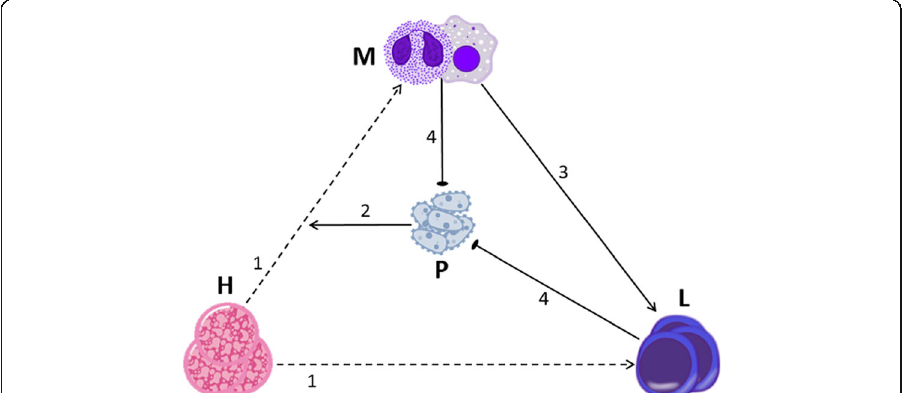
Fig. 1 A graphical display of Model V1. The model is based on four assumptions: 1. HSCs (H) continually differentiate into myeloid cells (M; neutrophils, macrophages) and lymphocytes (L). 2. The presence of pathogen (P) biases HSC differentiation towards the myeloid lineage. 3. Lymphocytes encounter myeloid cells that have phagocytized antigen, and expand their population in response. 4. Myeloid cells and lymphocytes inhibit pathogen growth. See Additional file 1 for the equations and parameters for Model V1. Regular, blunted, and dashed arrows indicate activation, inhibition, and differentiation,